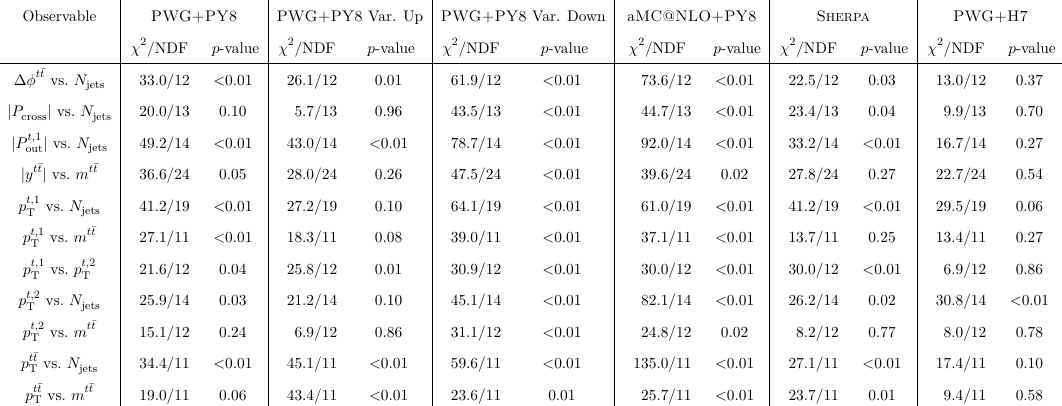
Table 10 . Comparison of the measured particle-level absolute double-differential cross-sections with the predictions from several MC generators. For each prediction, a χ 2 and a p -value are calculated using the covariance matrix of the measured spectrum. The number of degrees of freedom (NDF) is equal to the number of bins in the distribution.